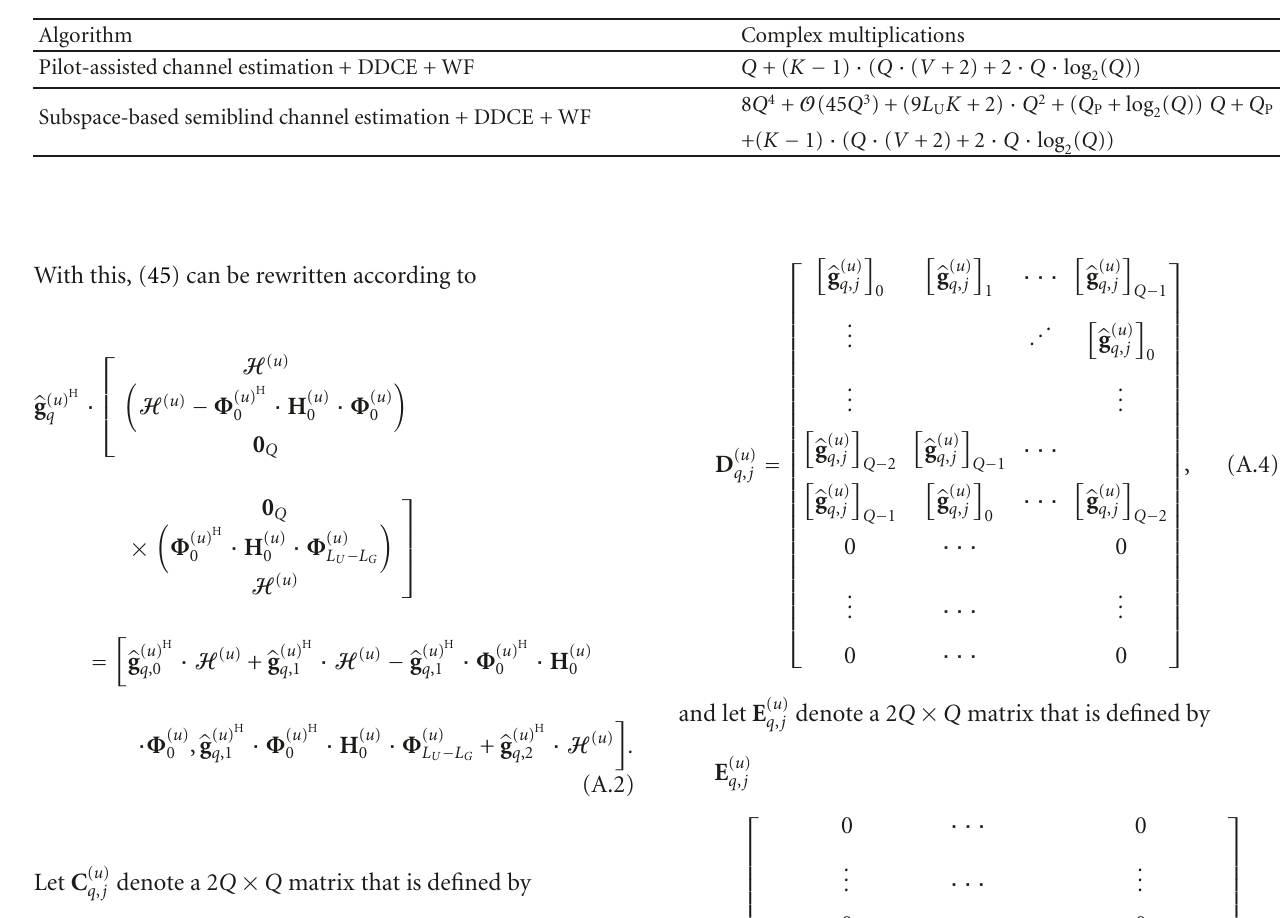
Table 3: Number of complex